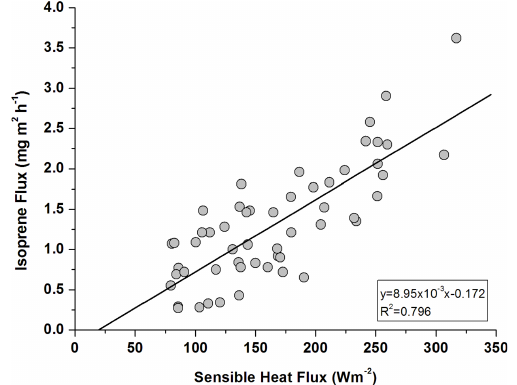
Fig. 5. Averaged isoprene fluxes for the whole CABINEX 2009 campaign versus the corresponding average sensible heat flux (Wm − 2 ) derived from eddy covariance of sonic anemometer tem- perature data, averaged to DEA measurement times.